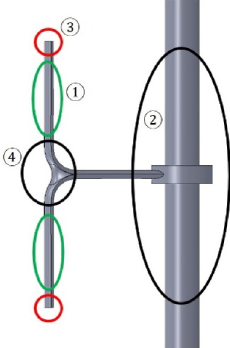
Fig. 4. Physical phenomena conditioning performance.